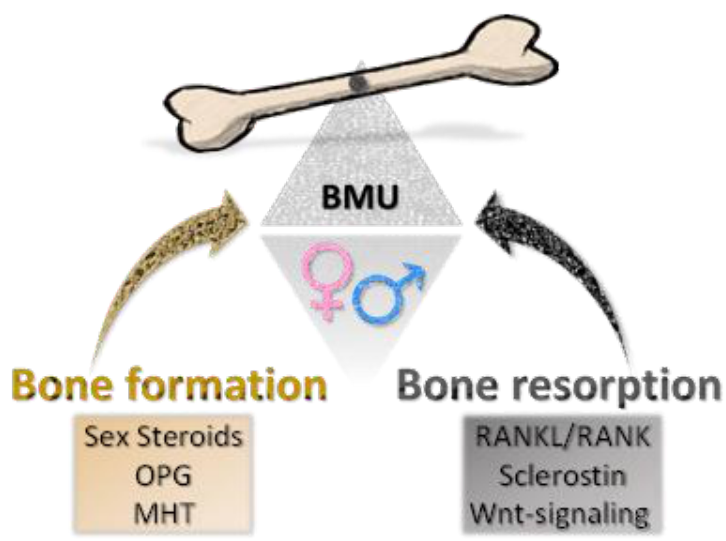
Figure 6. Different actors and effects on bone formation/resorption balance according to different sexes. BMU: Basic Multicellular Unit; OPG: Osteoprotegerin; MHT: Menopausal Hormone Therapy; RANKL: Receptor activator of nuclear factor kappa-B ligand; RANK: Receptor activator of nuclear factor kappa-Β.